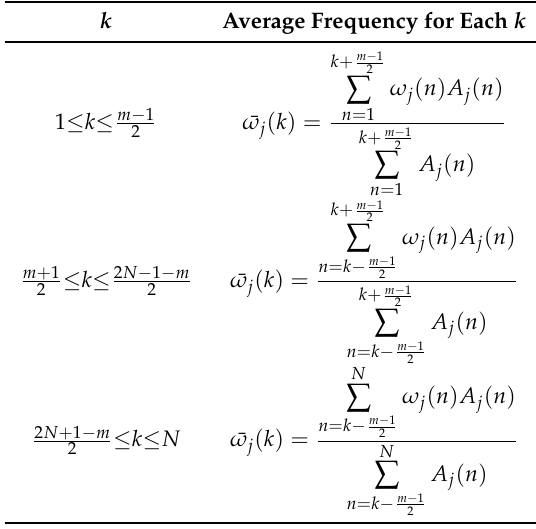
Table 1. Weighted Average Frequency Algorithm (WAFA) [19].